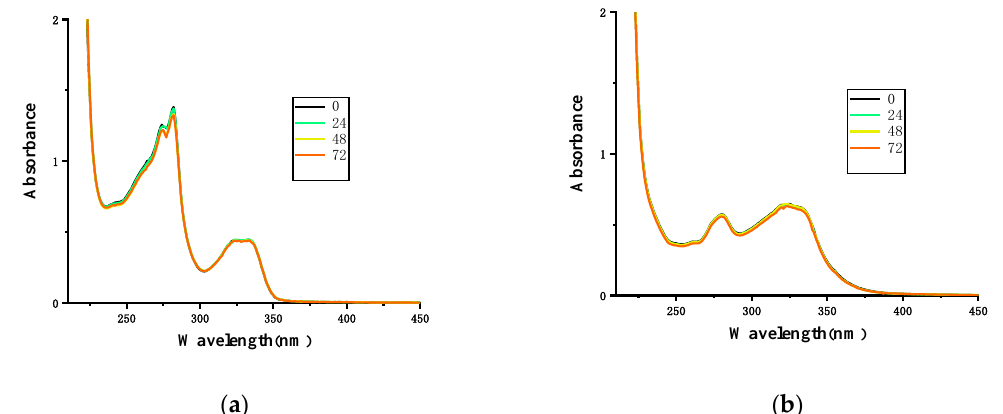
Figure 3. The UV-vis spectra of complexes ( a ) 1 and ( b ) 3 in PBS buffer solution over a period of 72 h.